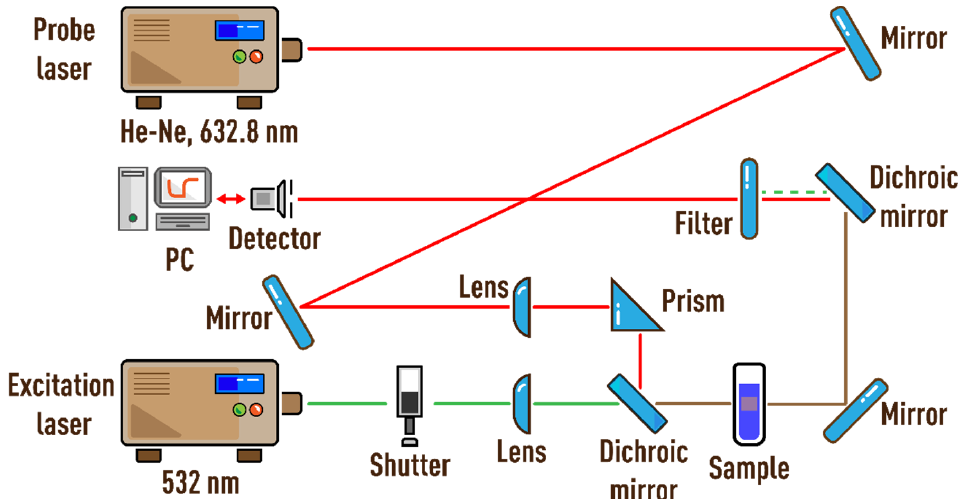
Figure 1. Schematic of the thermal lens setup. The signal from the detector is recorded every cycle. One cycle starts when the shutter opens, continues when the shutter closes, and ends when the shutter is reopened, after which the cycle repeats. The PC receives data from the ADC and the detector, which are processed in the original program (C++ programming, Borland Corp., Austin, TX, USA), where the measurement cycles are formed, displayed, and stored in the form of transient curves (signal intensity vs. time). The laser power was measured using an Optronics Nova II power meter (Ophir Optronics Solutions, Jerusalem, Israel). The operating parameters of the measurements are summed up in Table 2. Table 2. Thermal lens measurement parameters.